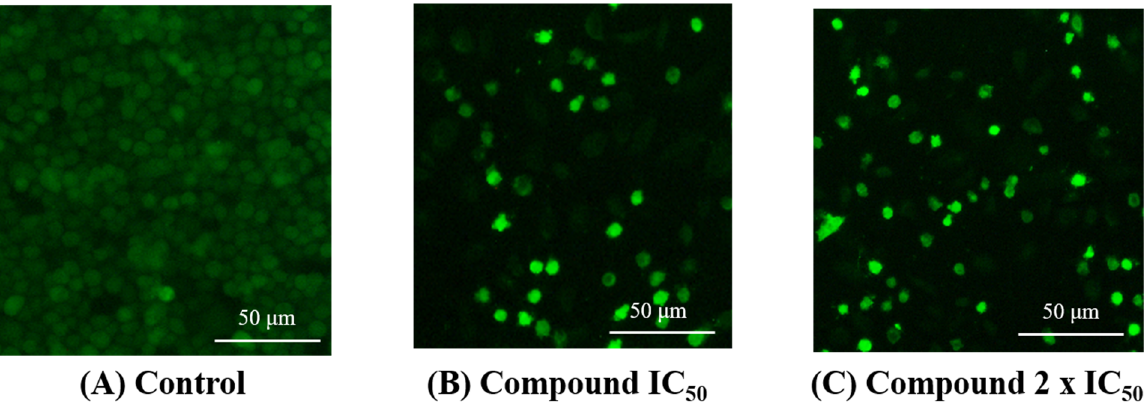
Figure 5. Production of ROS at IC 50 and 2 × IC 50 values ( A – C ), observed with green fluorescence by using 2,7-dichlorodihydrofluorescein diacetate (H2DCFDA) as a fluorescent dye. Images were captured under a high-resolution microscope (Nikon ECLIPSE Ni–U at 20) in the HeLa cells. The HeLa cells treated with the IC 50 and 2 × IC 50 of compound 4d displayed a bright green fluorescence emission of cells under a fluorescence microscope when compared with the untreated control HeLa cell lines, which appeared as a non-fluorescent field.